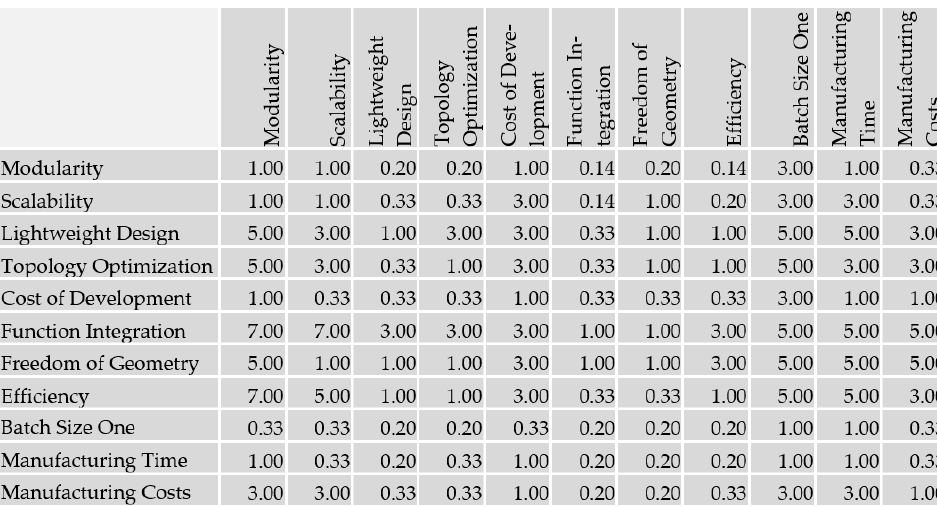
Figure 4. Extract of the AHP for the control unit housing.